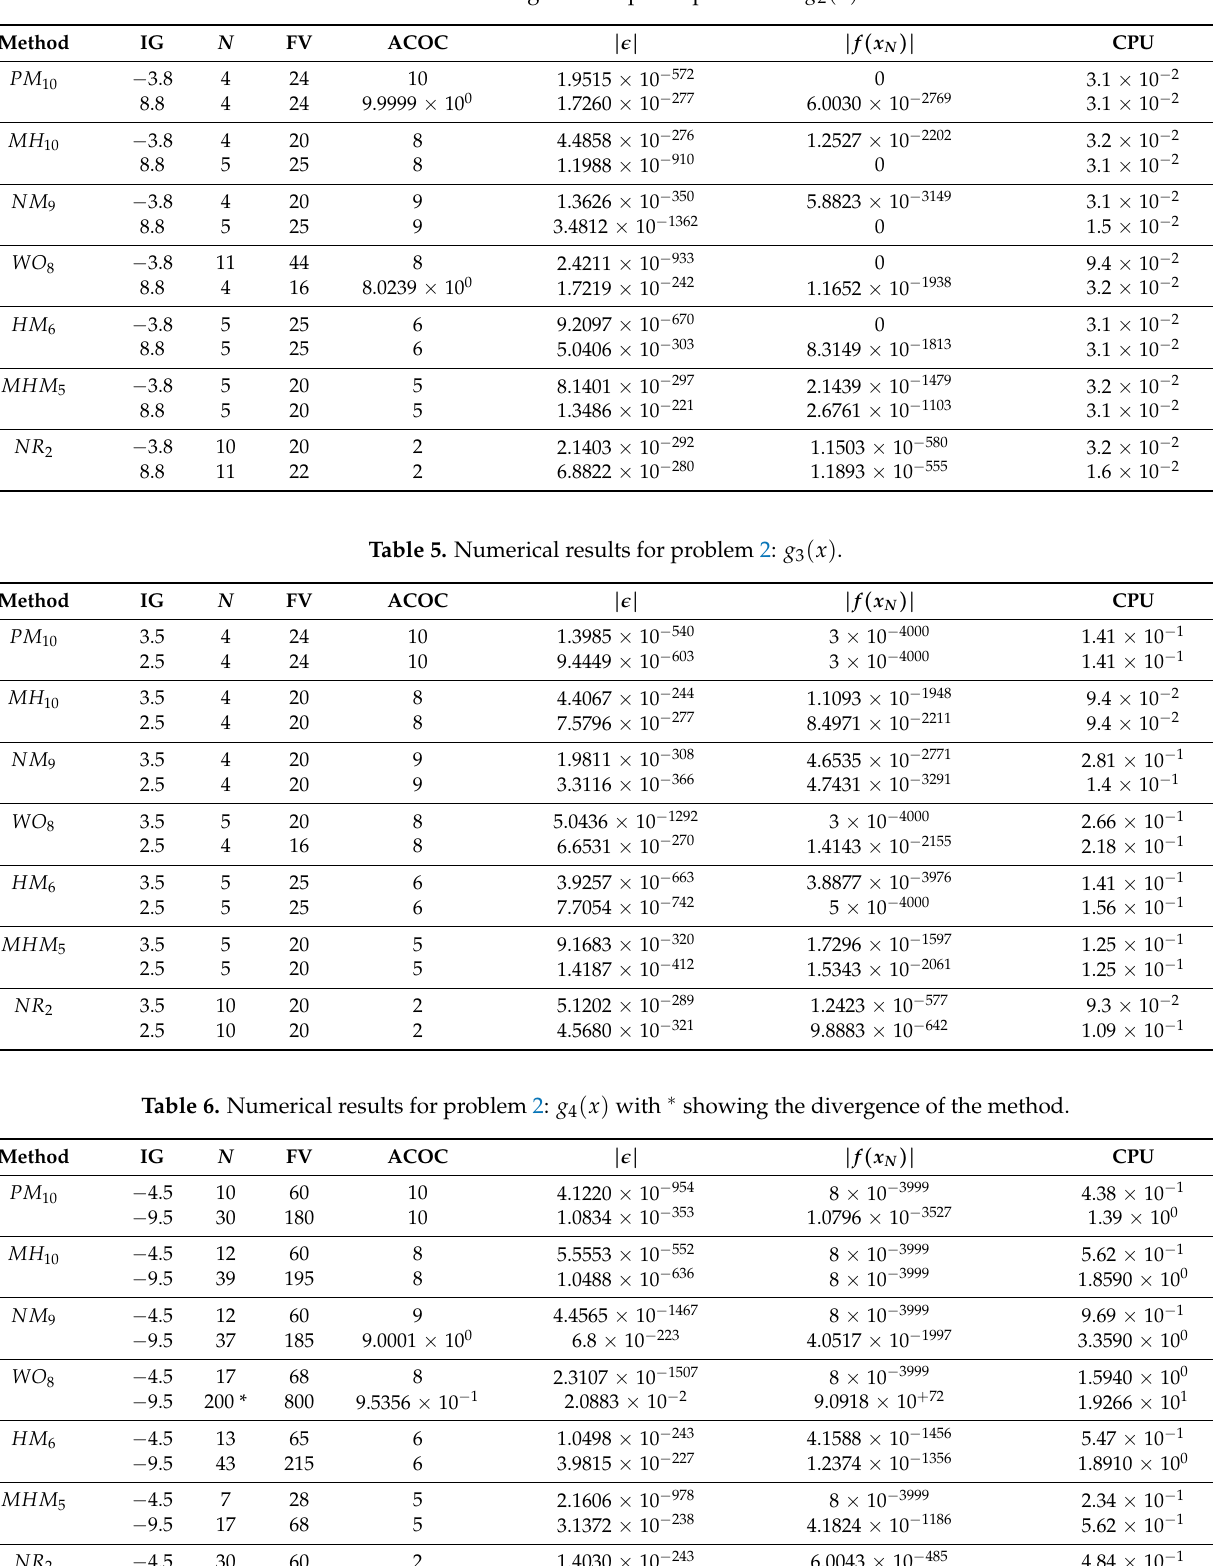
Table 4. Data using fixed step-size problem 2: g 2 ( x ) .